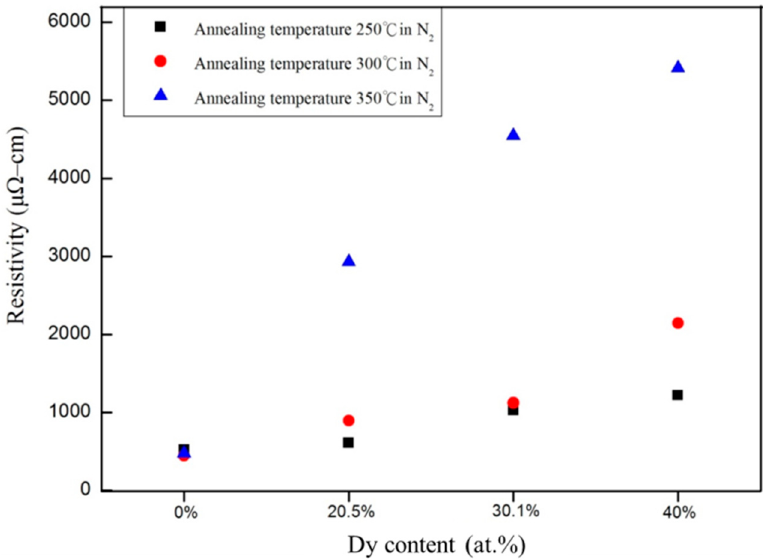
Figure 5. Room temperature resistivity of Cu–Mn films with various Dy contents annealed at different temperatures.